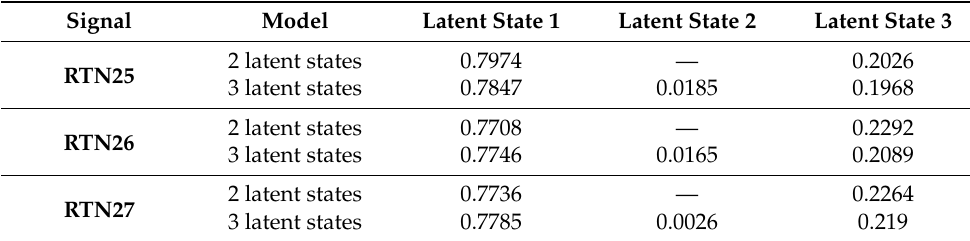
Table 2. Stationary distribution for the different traces.